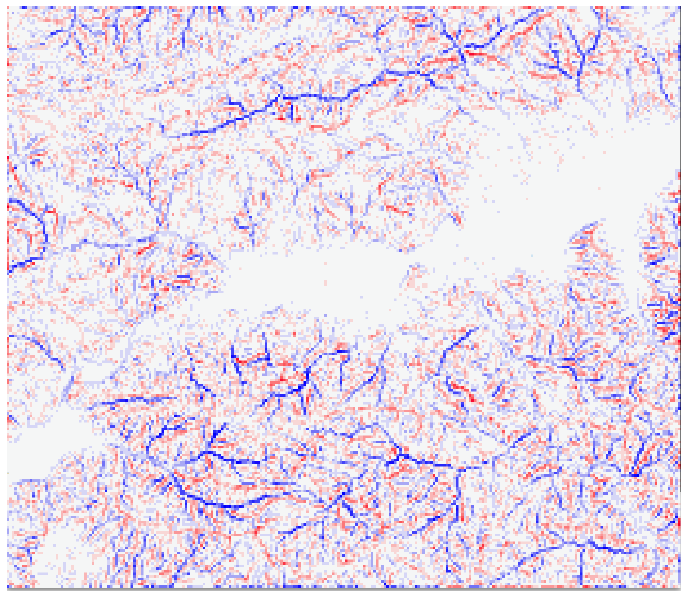
Figure 2. TPI terrain complexity for the river Soummam in Algeria (see also Figure 5). Red lines represent higher points, difficult to overcome and blue lines are for lower points, difficult to reach. The white zone signals a flat ground without remarkable obstacles, the case of Soummam banks. This grid is 262 × 226 points, representing 30 × 25